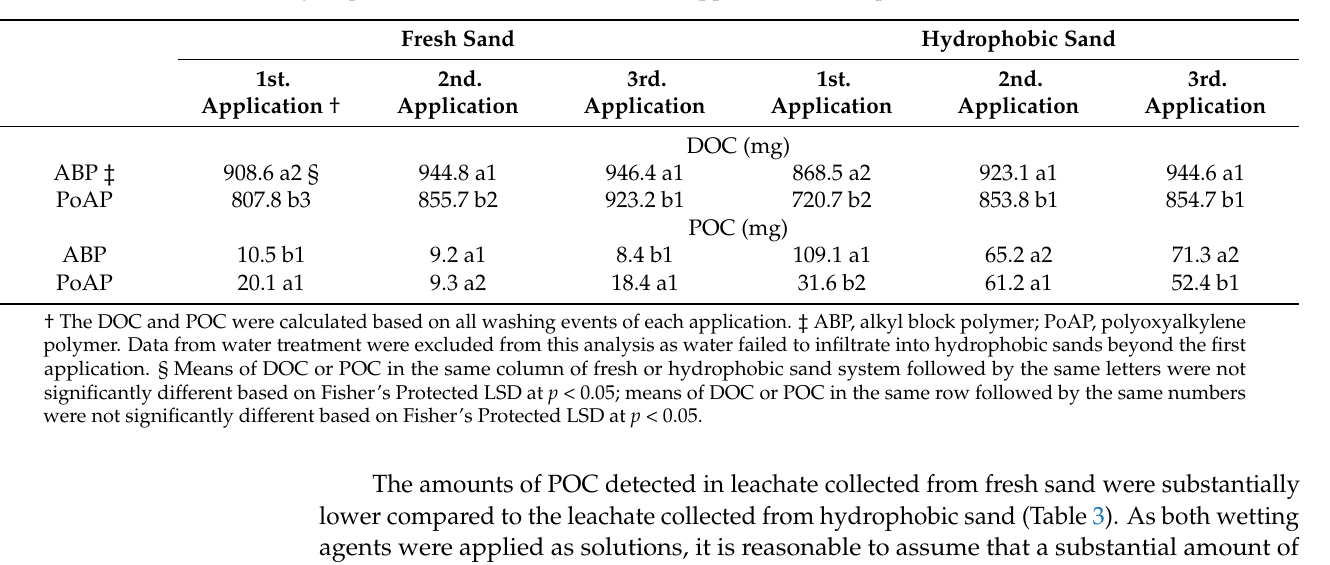
Table 3. Effects of wetting agents on the dissolved and particulate organic carbon (DOC and POC, respectively) in leachates collected from fresh and hydrophobic sands after each treatment application and sequential